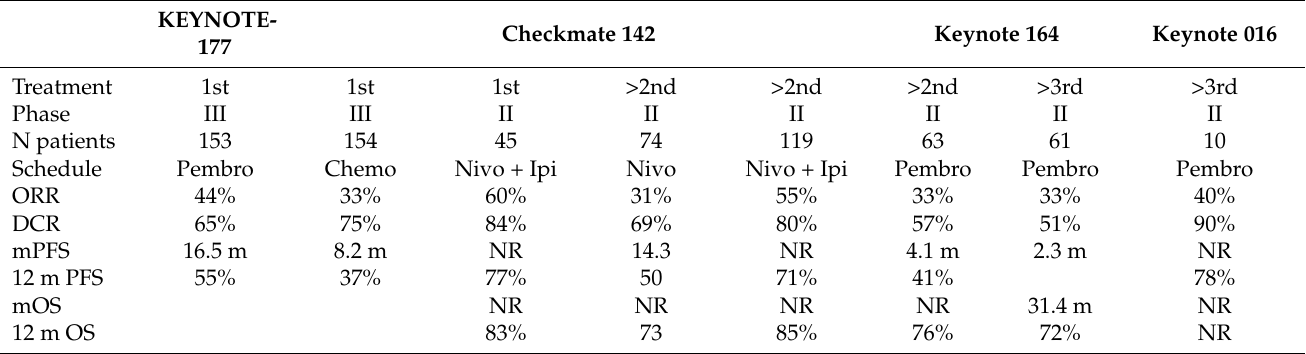
Table 1. Clinical outcome in pivotal trials involving dMMR/MSI-H mCRC